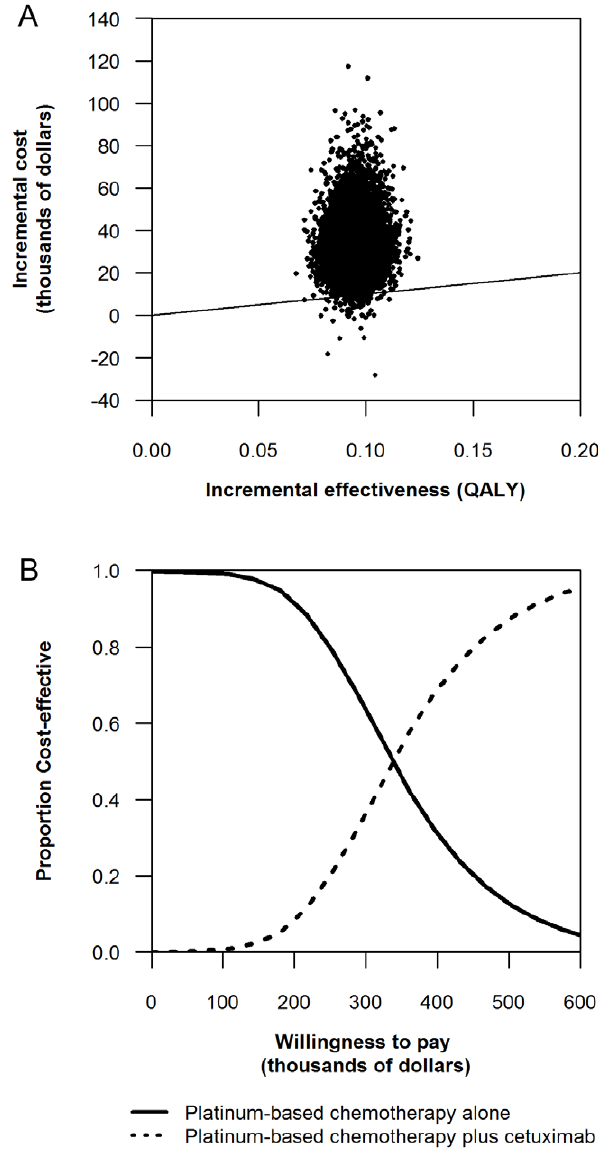
Figure 3. Incremental cost-effectiveness scatter plot and cost effectiveness acceptability curves of platinum-based chemo- therapy plus cetuximab versus platinum-based chemotherapy alone. Each graph was based on 10000 replicates. 3a Incremental cost- effectiveness scatter plots. 3b Cost effectiveness acceptability curves.